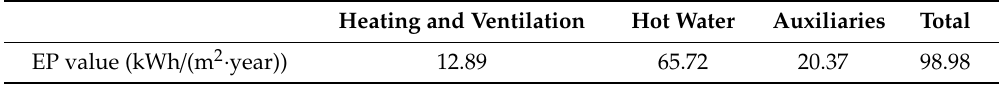
Table 19. The annual EP demand (kWh / (m 2 · year)) for the multi-family building at Akacjowa Street in